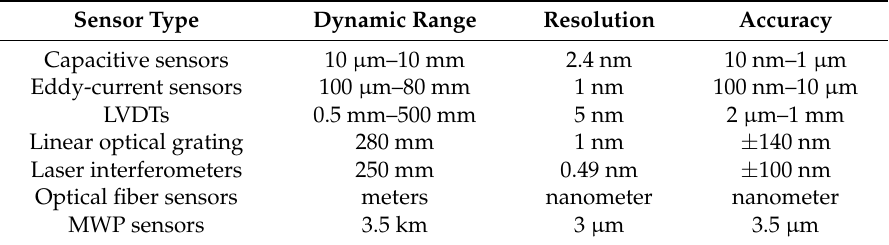
Table 1. Summary of the characteristics of the major types of displacement